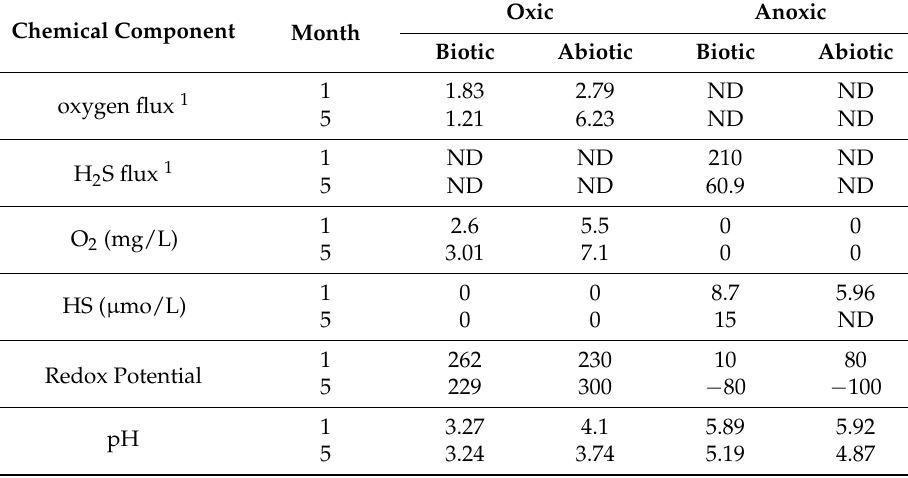
Table 2. Chemical and physical properties of sediment (diffusivity and flux) and water cap (pH) for all incubations for each month sampled. Each number represents an average for each experimental condition. ND (not detected) was recorded for certain samples as oxygen was not present in the Anoxic, and H 2 S was not found in the abiotic mesocosms or the